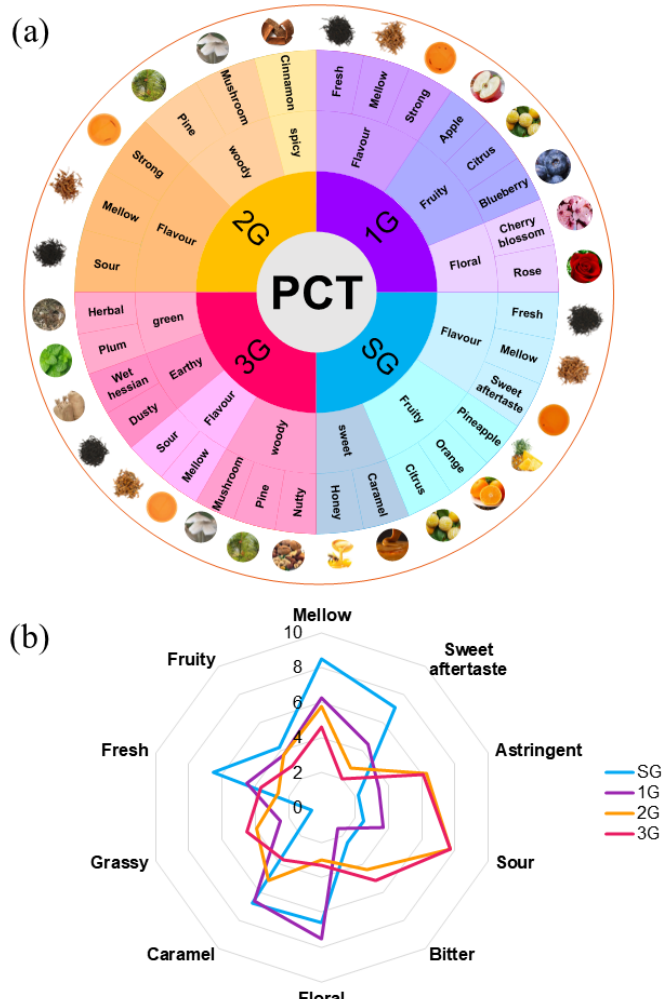
Figure 2. Sensory evaluation of the PCT standard samples. ( a ) Flavor wheel. ( b ) Sensory evaluation radar chart. Table 2. The geometric mean ( M ) values of the sensory attributes of PCT.